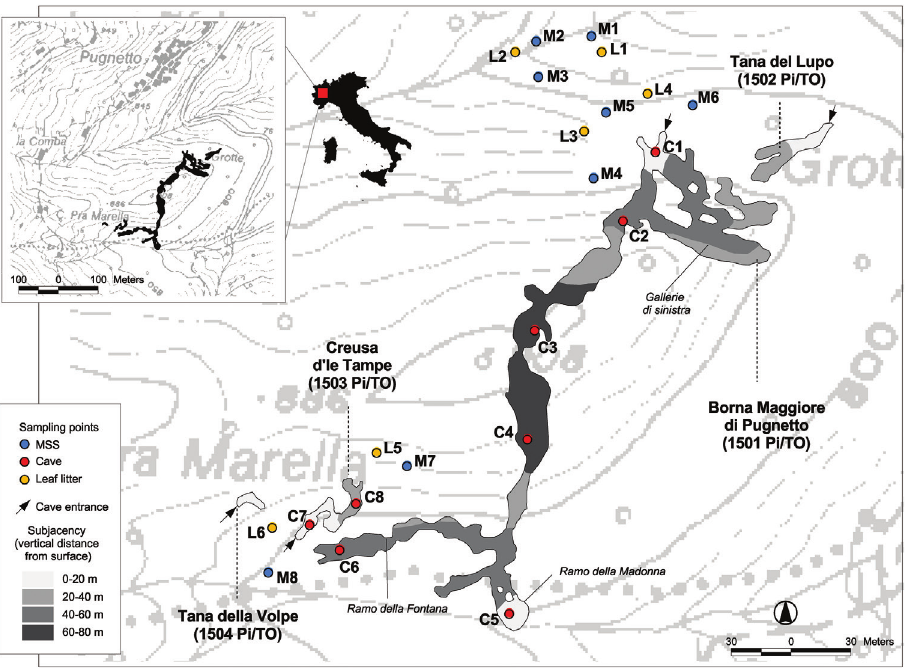
Figure 2. Map of the study area. The shape and the topographic position of the four caves (Borna Mag- giore di Pugnetto, Tana del Lupo, Creusa d’le Tampe, Tana della Volpe) was obtained from the original planimetric drawings of Muratore (1946). The position of the sampling plots in caves (“cave triplets”, C1–C8), in the MSS (“MSS triplets”, M1–M8) and in the leaf litter (“epigean”, L1–L6) are represented by coloured dots. The different sectors of the cave are coloured with different shades of grey representing the subjacency – i.e., vertical distance from the surface – according to Motta and Motta